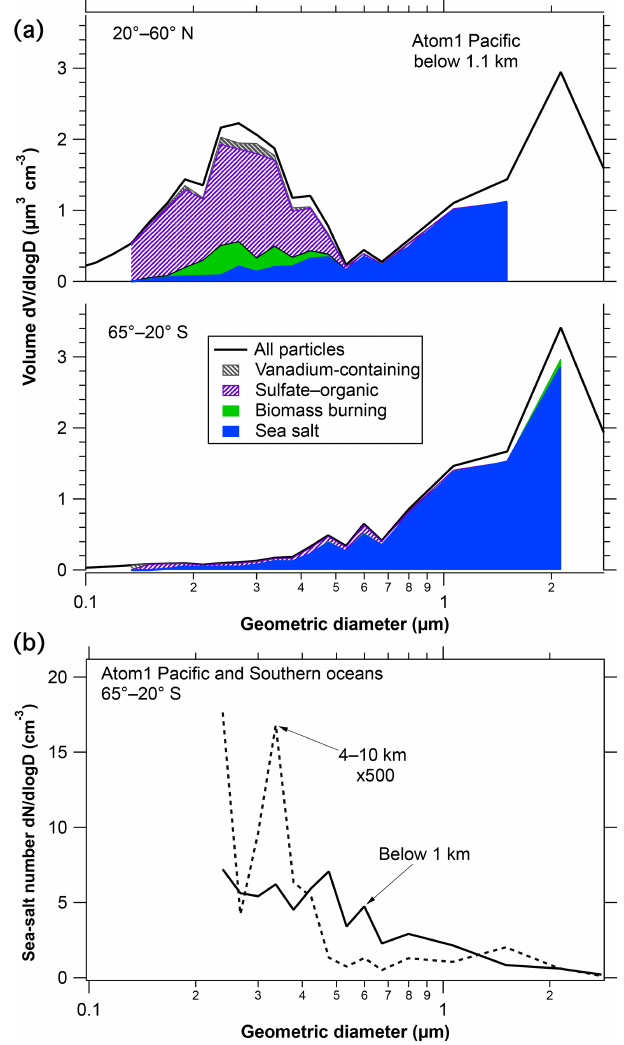
Figure 4. Size distributions of sea-salt particles in the marine boundary layer. Panel (a) shows how the total size distribution (black line) is multiplied by PALMS composition at each size to ob- tain the volume of sea-salt particles. White areas below the size dis- tribution curves represent unknown compositions or, at the largest and smallest diameters, insufficient data to assign composition. The reduced concentration above about 3µm diameter is because the aircraft inlet does not efficiently transmit larger particles. Panel (b) compares the number size distributions at low and high altitudes.